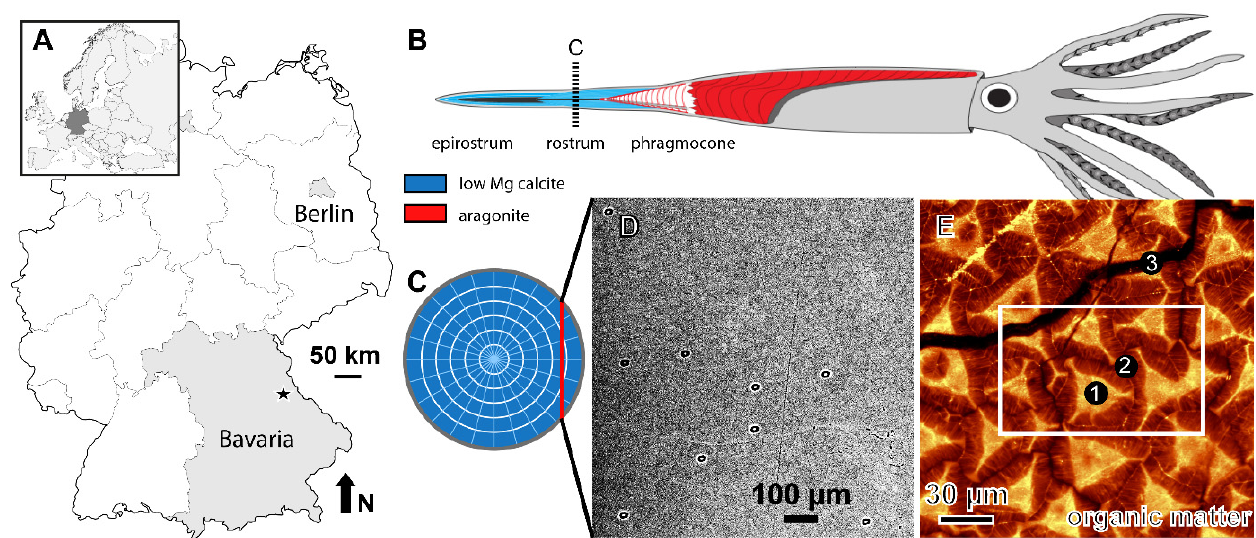
Figure 1. ( A ) Map of Central Europe and Germany with fossil collection locality (star). ( B ) Simplified reconstruction of the belemnite animal with its aragonitic phragmocone, calcitic rostrum, and epirostrum (gray, soft tissue). ( C ) Cross section of the rostrum with radially arranged fibers and growth increments (white). Red line indicates section plane, perpendicular to the calcite fibers, used for analyses resulting in the surface shown in ( D ). ( D ) Backscattered electron image of the analyzed polished, thick section surface showing SIMS pits. ( E ) Raman image (150 µm × 150 µm, resolution ~250 nm), showing the background fluorescence distribution, which is indicative for the presence of organic matter within the belemnite rostrum. The trigonal pyramids formed by the first calcite phase (1, CP1) are characterized by the highest amount of fluorescence within the Raman spectra, whereas Raman spectra obtained in the second calcite phase (2, CP2) show significantly less fluorescence. The fracture (3) filled with late diagenetic calcite (not further considered) shows no fluorescence in the Raman spectra. The white box refers to the field of view in Figure 2.